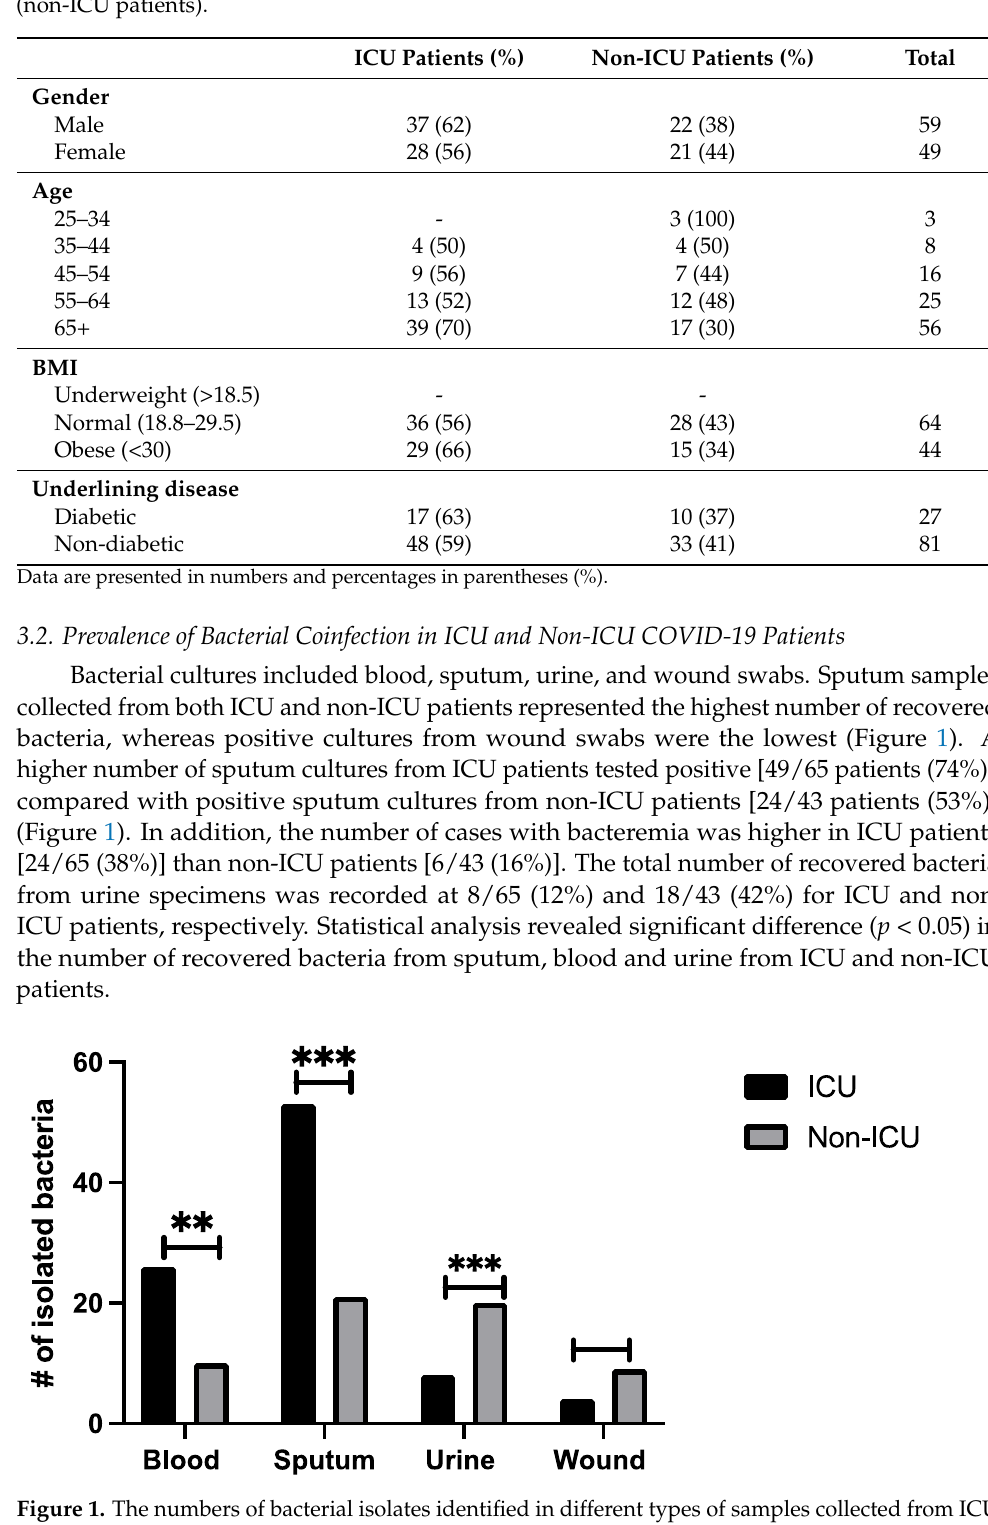
Table 1. Demographic and clinical characteristics of COVID-19 patients admitted to ICU and wards (non-ICU patients).